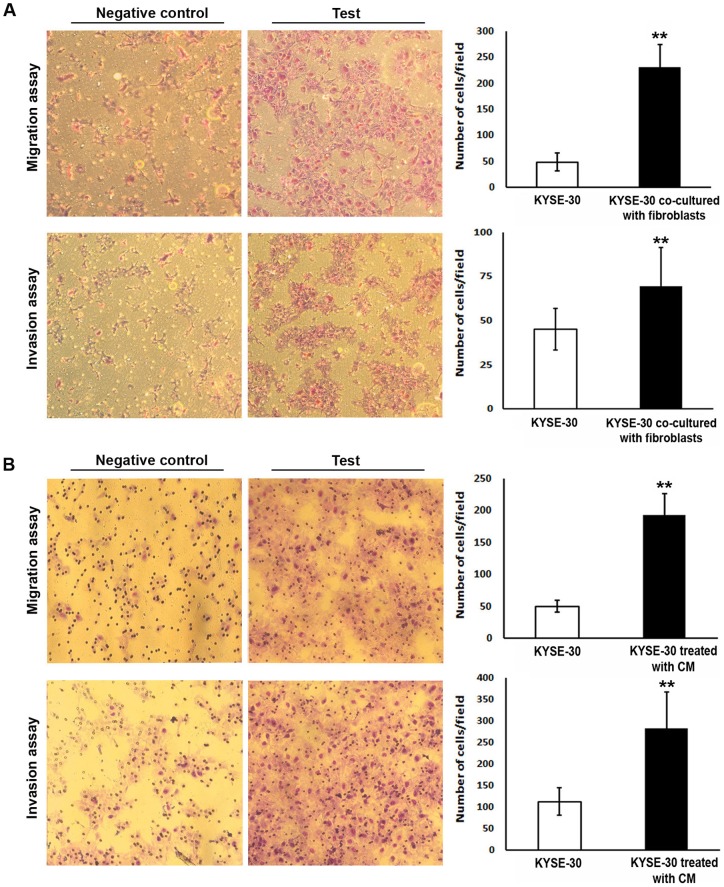
Cell migration and invasion properties of KYSE-30 cells are increased upon co-culture with HGF-1.A) KYSE-30 cells juxtaposed with HGF-1 fibroblasts showed a significantly higher potential to migrate (P<0.0001) or invade (P = 0.0001) through the coated 8.0 μm pore-sized membrane as compared to the KYSE-30 cells not grown co-culture with normal fibroblasts. Images of representative microscopic pictures are shown on the left; B) 3 day old conditioned media from HGF-1 fibroblasts could significantly induce migration and invasion of KYSE-30 cells (P<0.0001 for both experiments). Images of representative microscopic pictures are shown on the left.